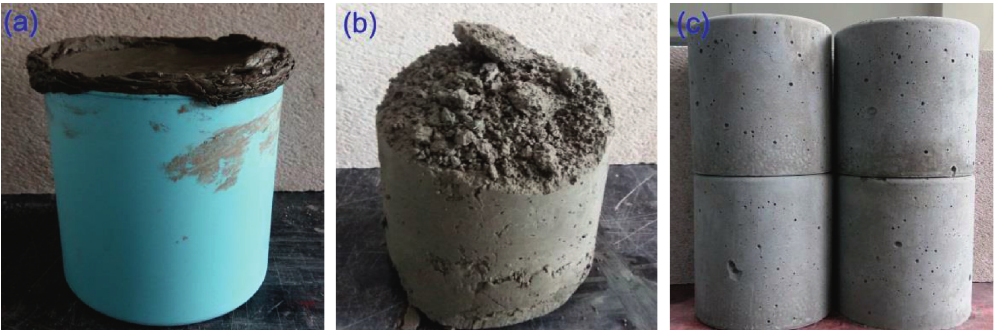
Figure 1: The specimens under microwave curing.